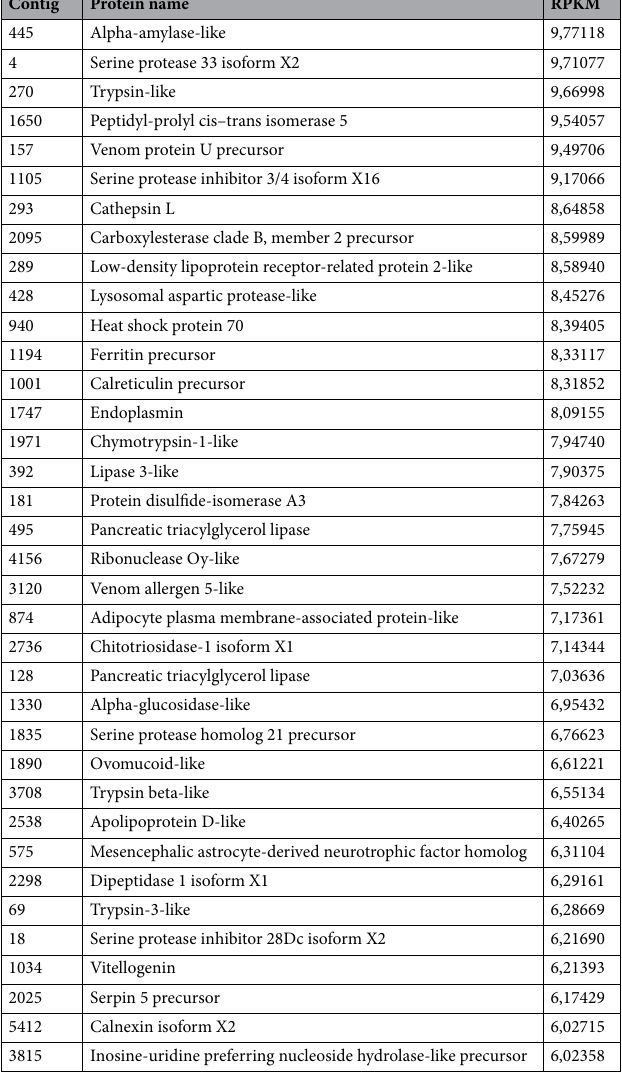
Table 1. Most expressed T. sinensis venom proteins. Proteins identified by SDS-PAGE and LC–MS/MS of venom extract, ordered by descending RPKM values. Expression levels are reported as log2-transformed RPKM